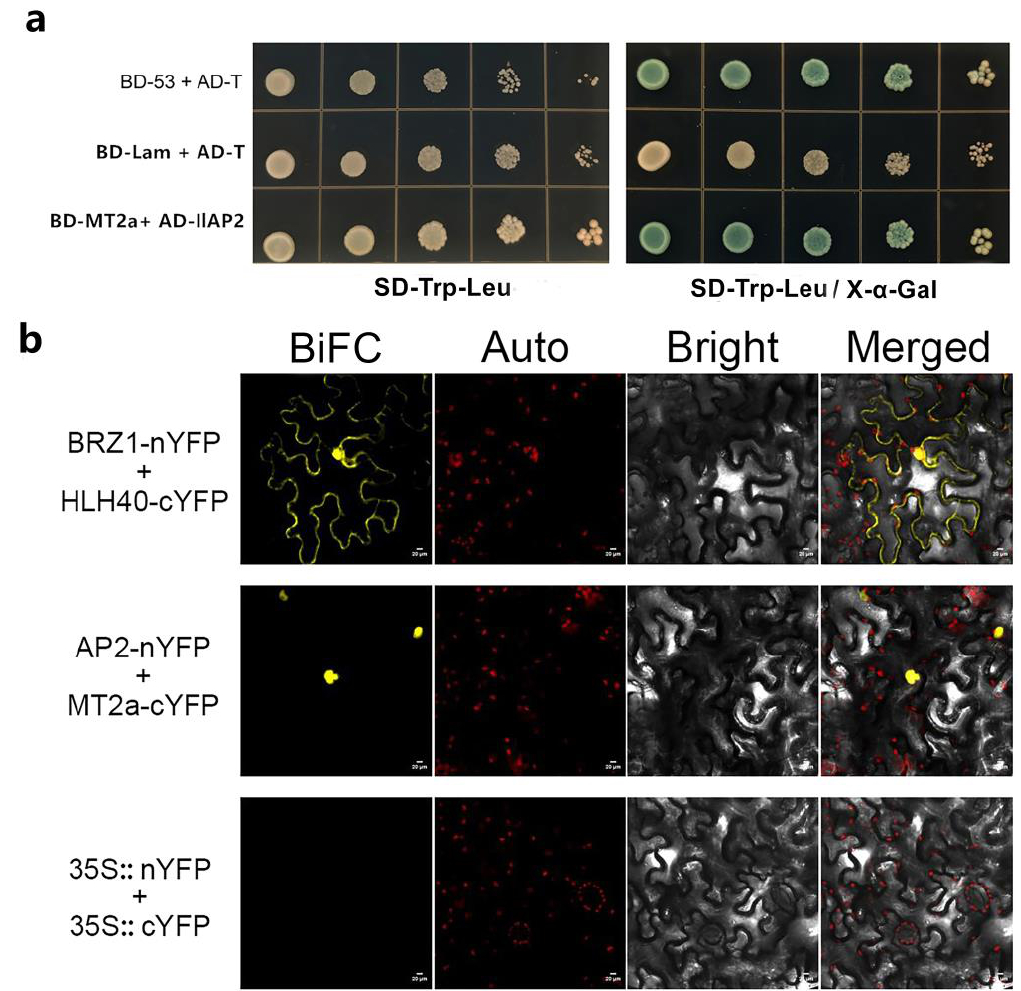
Figure 3. Interaction between IlAP2 and IlMT2a: ( a ) yeast two-hybrid analysis of IlAP2 and IlMT2a, with BD-53 + AD-T as positive control and BD-Lam + AD-T as negative control; and ( b ) BiFC analysis of IlAP2 and IlMT2a, with BRZ1-nTFP + HLH40-cYFP as positive control and 35S::nYFP + 35S::cYFP as negative control. Ruler: 20 μm.